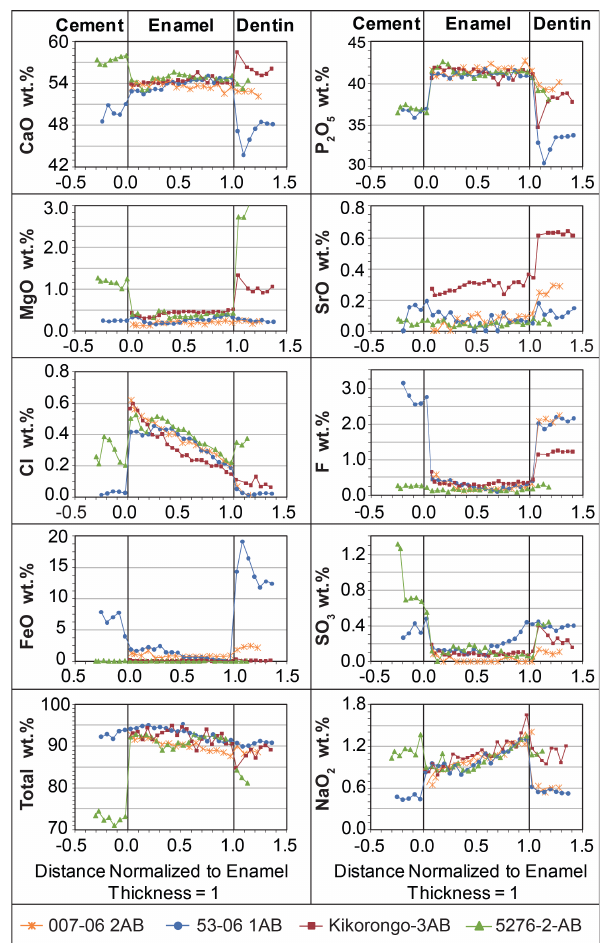
Fig. 4. Chemical variations along selected profiles of molar teeth from the outside margin through cementum, enamel into dentin. Note the different concentrations in enamel, cement and dentin, but similar element distribution patterns in enamel from modern (Zoo S276, M3) and fossil specimen from Lake Albert (00706, molar frag; 5306, molar frag.) and Lake Kikorongo, (M3). The distance is normalized to the length of the enamel=1. Location of the profiles is shown in Fig. 1. Data are given in Tables S1–4 in the